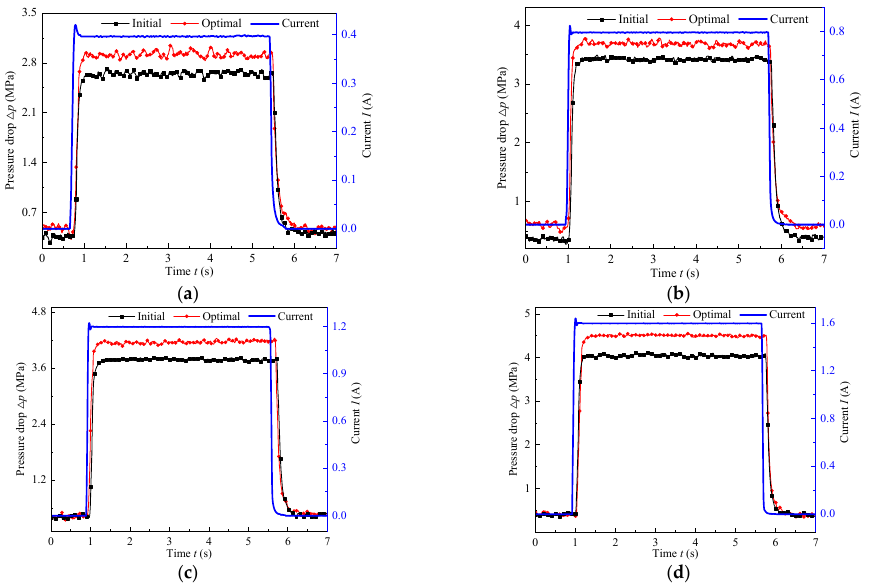
Figure 18. Pressure drop change of the initial and optimal MR valve under different currents: ( a ) 0.4 A, ( b ) 0.8 A, ( c ) 1.2 A, ( d ) 1.6